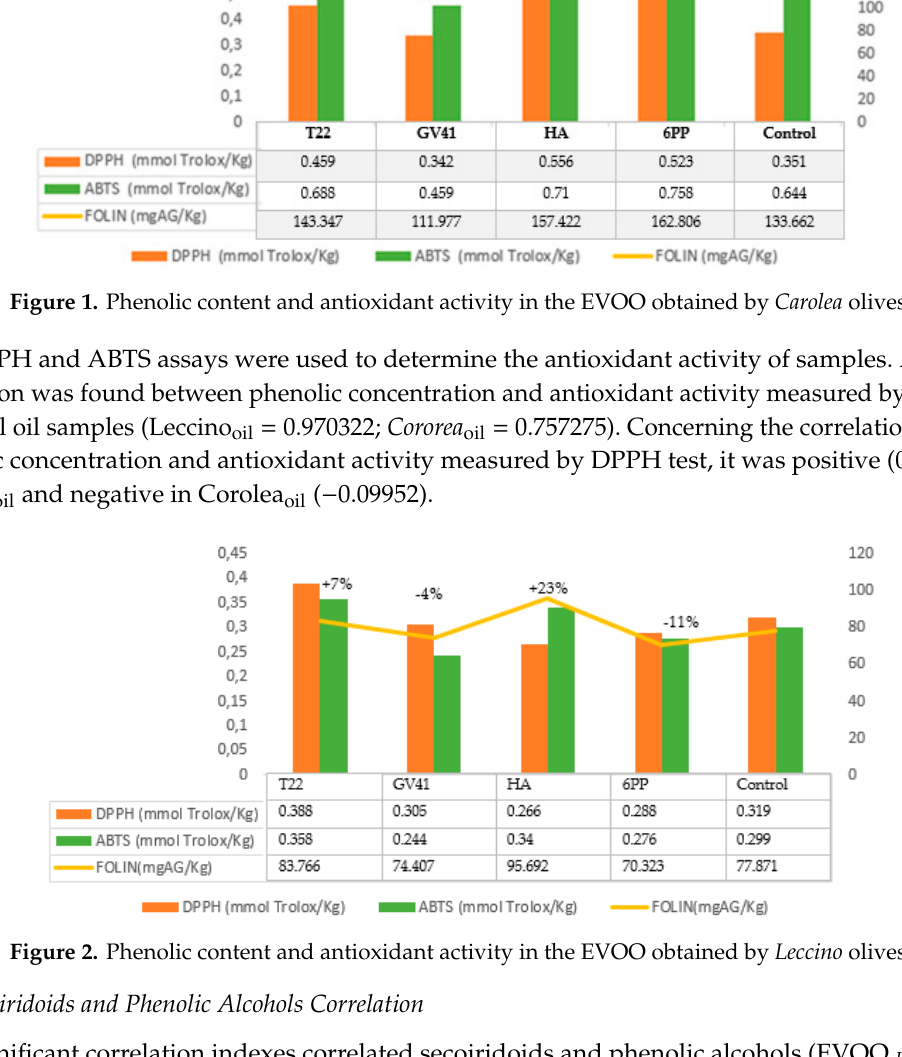
Figure 3. Correlation graphs of secoiridoids and phenolic alcohols. 2.4. Variation (%) of the Most Representative Phenolics T22 strain determined in both oil samples an increase of the oleuropein-aglycon mono aldehyde of ≅ 45%. In the EVOO Carolea , was shown a remarkable negative variation (%) of ligstroside decarboxymethyl-aglycone (Figure 4).